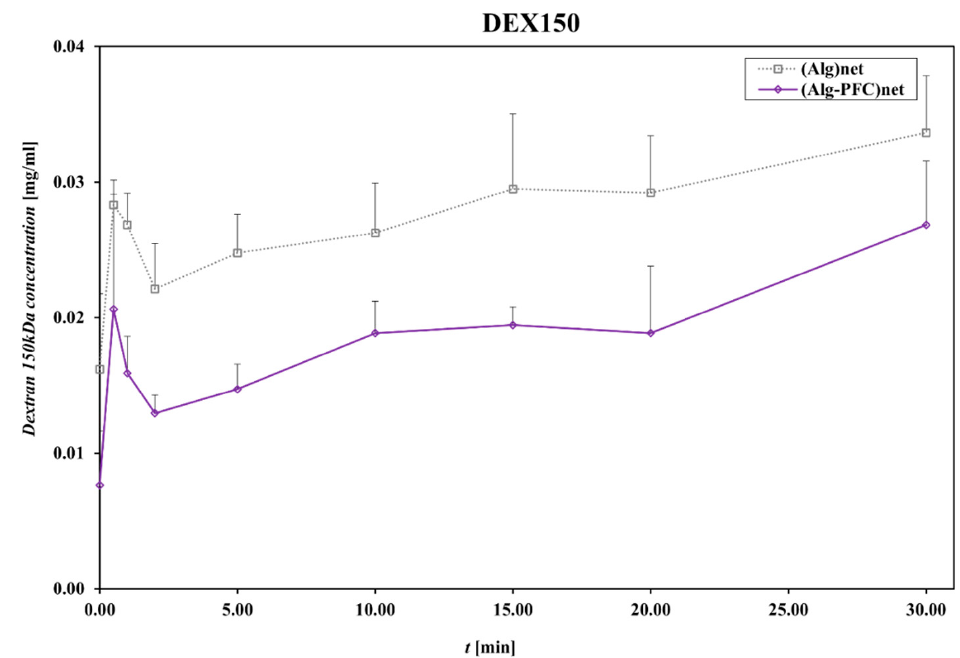
Figure 6. Dextran150 concentration in the function of time during permeation through the membrane. Key to symbols: (ALG-PFC) net —alginate–perfluorooctyl cross-linked; (ALG) net —alginate cross-linked. The values are presented as mean value ± SD ( n = 6).